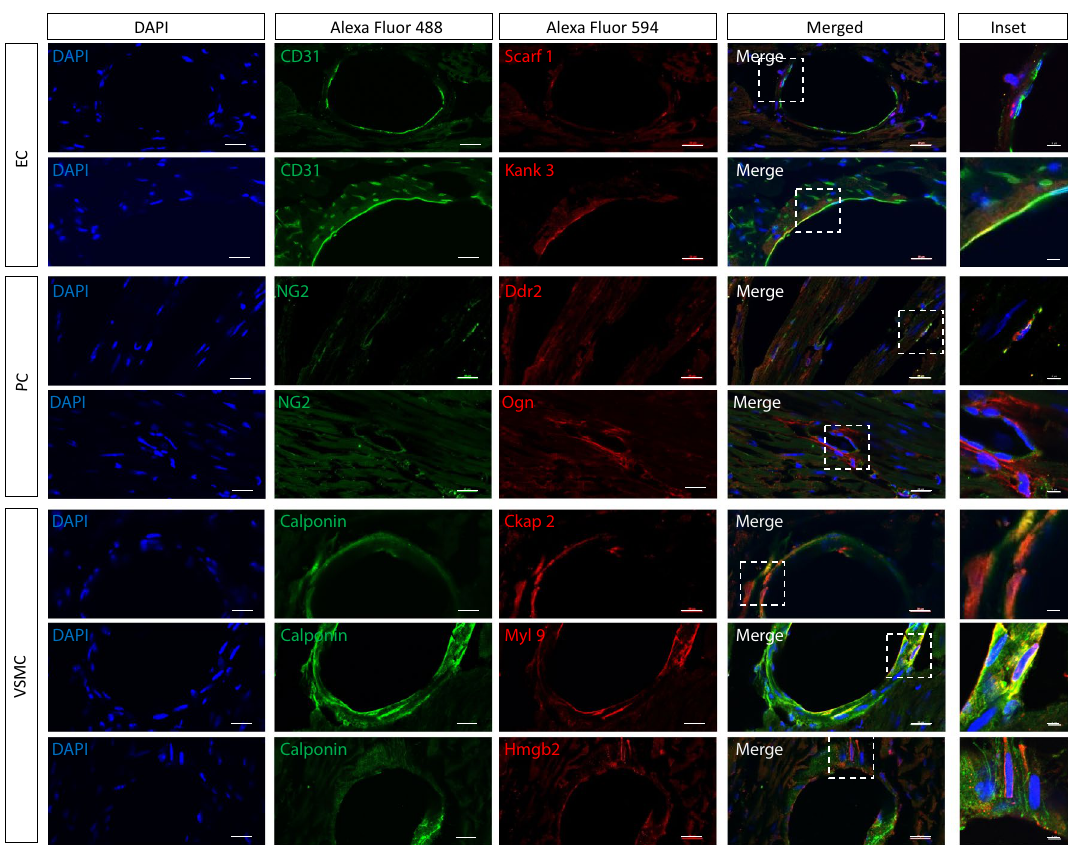
Figure 7. Validation of novel differentially expressed markers by immunohistochemistry of young adult mouse heart. IHC of 10-week-old male mouse heart, double labelling with novel differentially expressed markers identified by proteomic analysis of cell cultures (Figs. 6 and Supplemental Fig. S3). Novel markers (Alexa Fluor 594) are double-labelled with classical cell-specific markers (Alexa Fluor 488): CD31 for ECs, NG2 for PCs, calponin-1 for VSMCs; scale bar (DAPI, Alexa Fluor 488 and 594, merged), 20 µm, scale bar (inset), 5